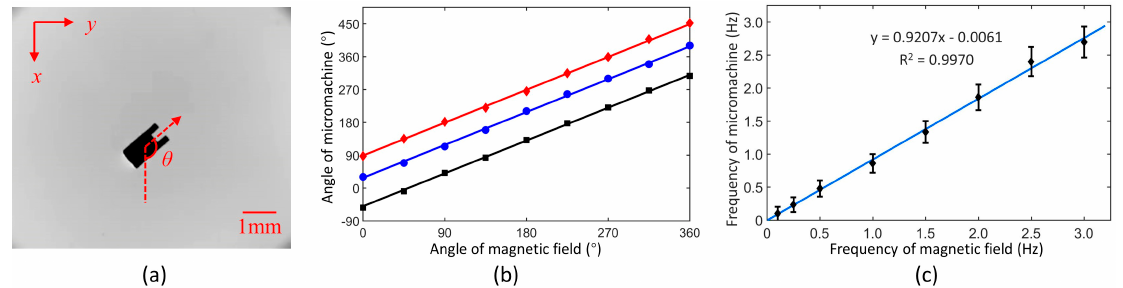
Figure 6. ( a ) Original image and angle definition of the micromachine under the magnetic field. ( b ) Angle relation of micromachines to the magnetic field. ( c ) Dynamic response of the micromachine’s rotation under the rotate magnetic field.